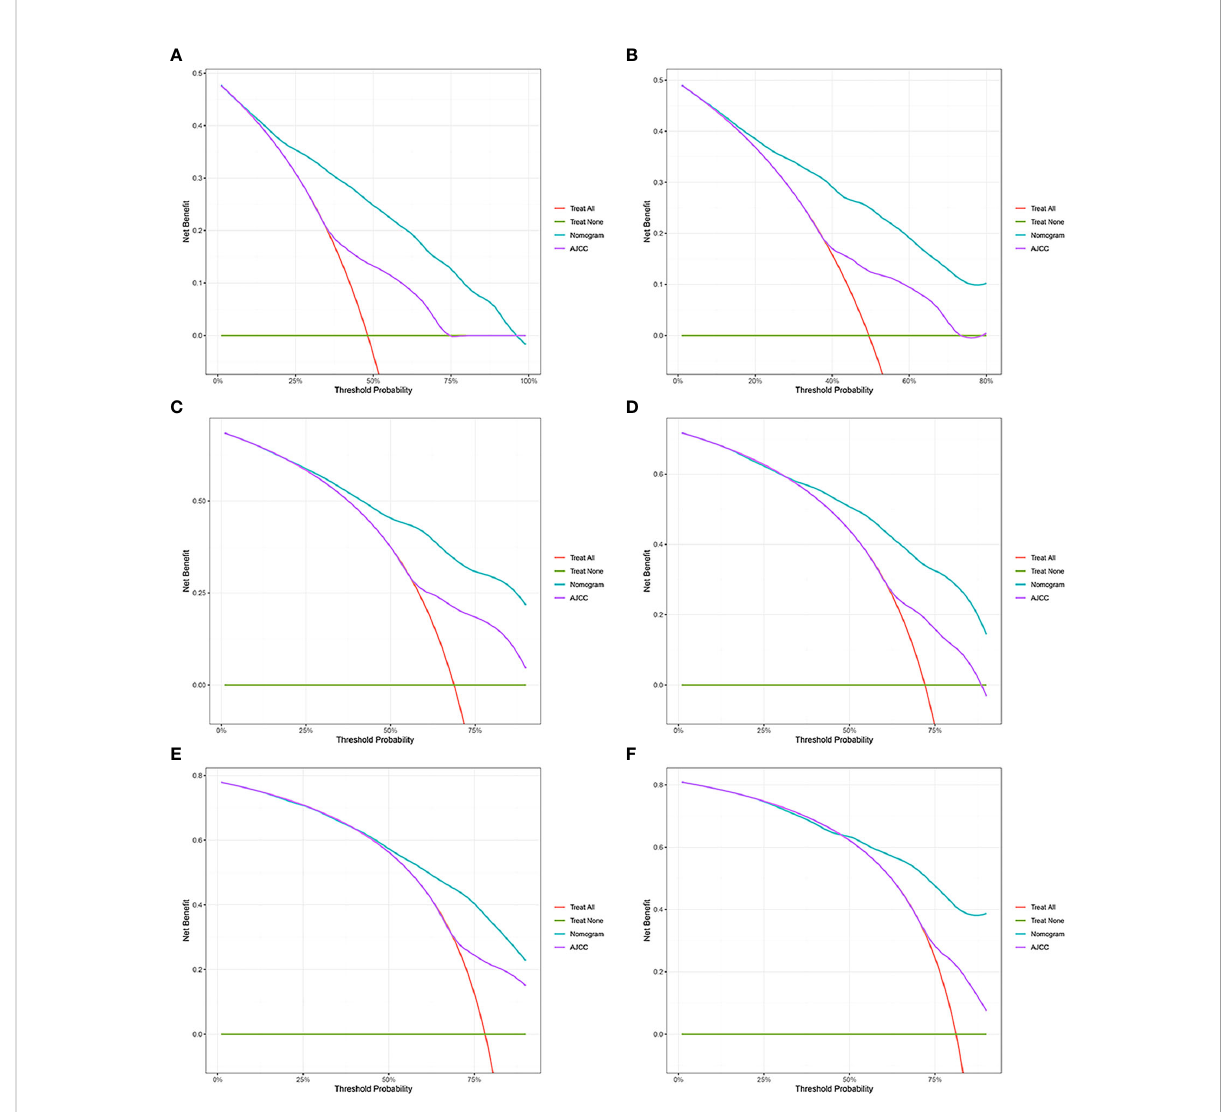
FIGURE 4 Decision curve analysis. (A, C, E) DCA curves of 1-year, 2-year, and 3-year CSS in the training cohort. (B, D, F) DCA curves of 1-year, 2-year, and 3-year CSS in the validation cohort. DCA, decision curve analysis; CSS, cancer-speci fi c